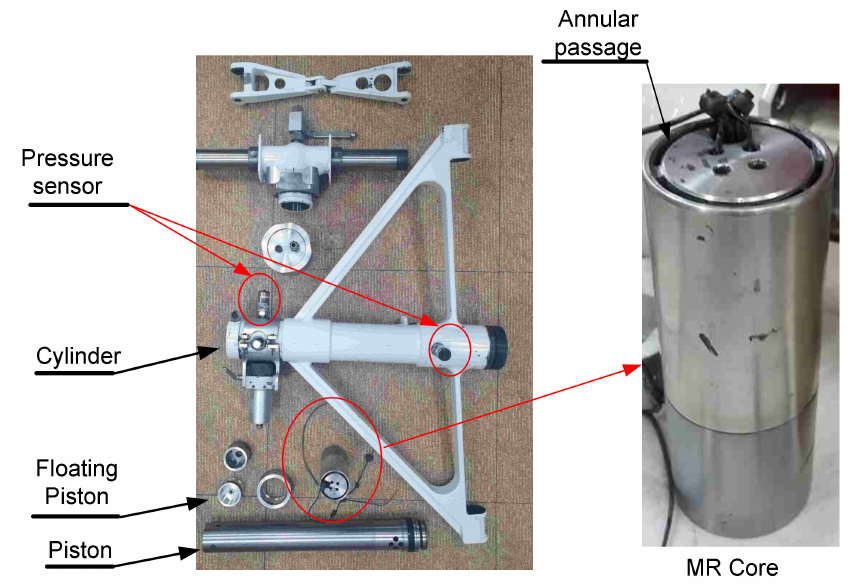
Figure 4. Components of the MR damper (landing gear without